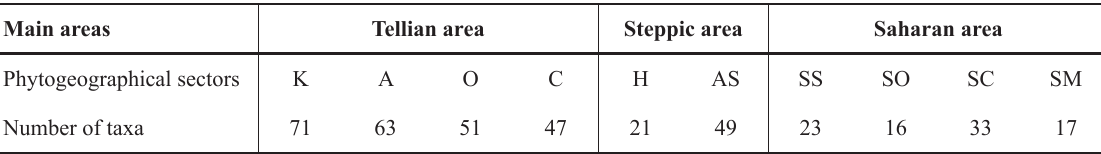
Table 5 – Distribution of the tree taxa richness in the floristic regions (phytogeographical sectors) of Algeria, organized according to the 3 main areas. Abbreviations. K: Kabylian-Numidian sector; A: Algiers sector; O: Oran’s sector; C: Constantine’s sector; H: High Plateaus sector; AS: Saharan Atlas sector; SS: Northern Saharan sector; SO: Western Saharan sector; SC: Central Saharan sector; SM: Southern Saharan